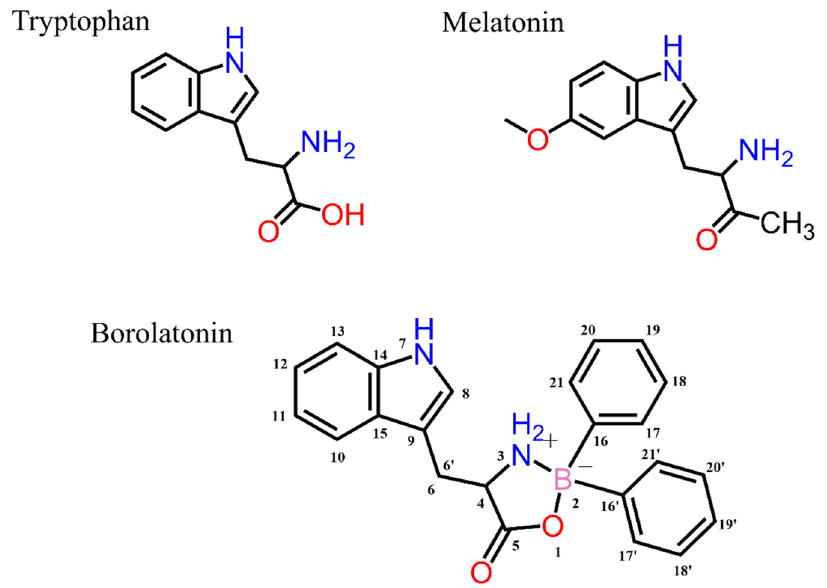
Figure 1. The chemical structures of tryptophan, melatonin, and borolatonin (adduct of tryptophan and 2-APB).